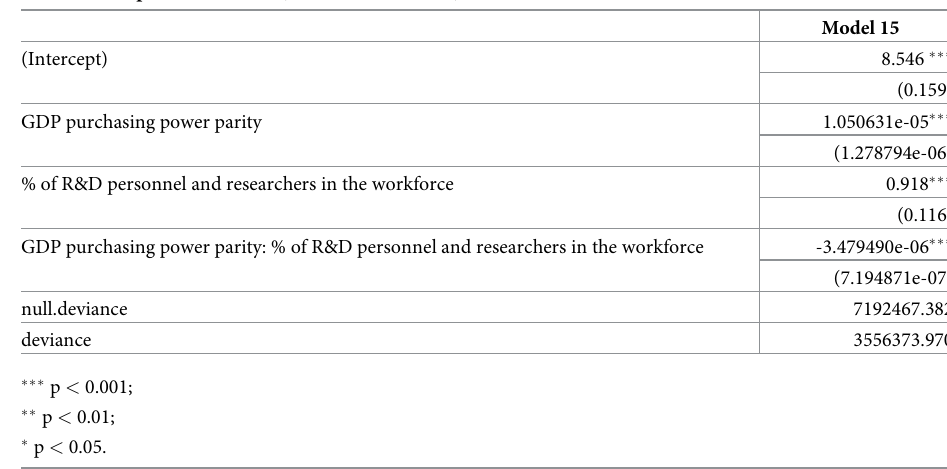
Table 9. European models III. (DV: download